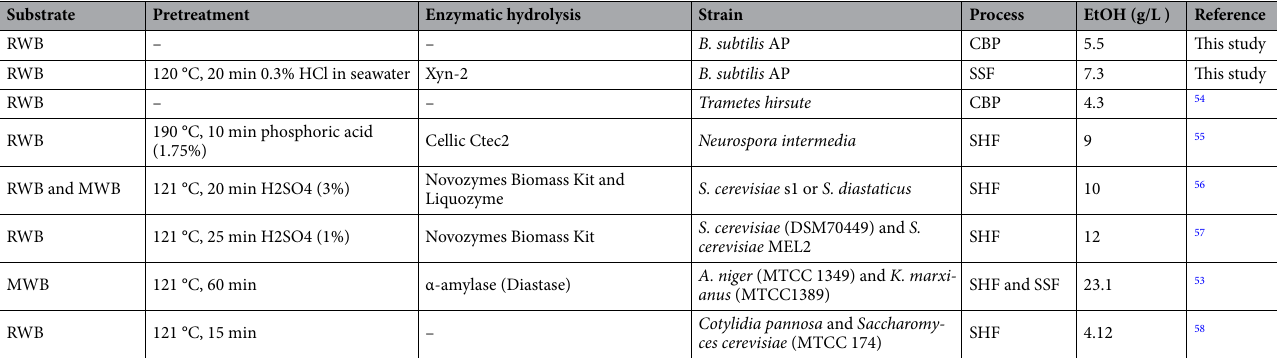
Table 2. Bioethanol production by various organisms using raw wheat bran (RWB) and milled wheat bran (MWB) in different studies. CBP consolidated bioprocessing, SSF simultaneous saccharification and fermentation, SHF separate hydrolysis and